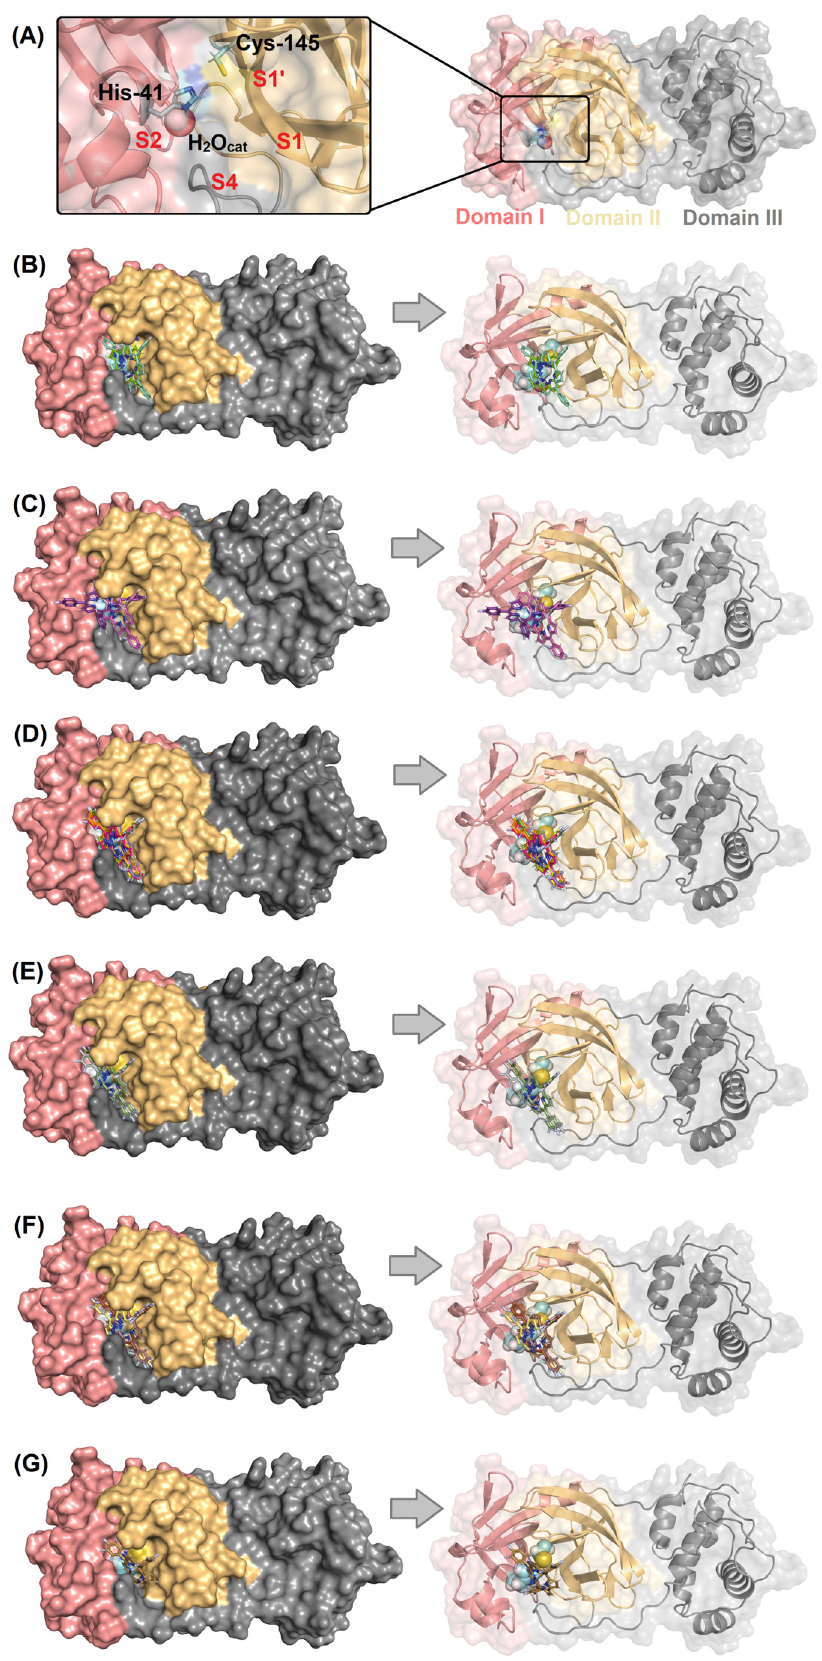
Figure 2. ( A ) The 3D structure for M pro (PDB code: 6LU7) highlighting the catalytic Cys-His dyad (as stick in cyan) and catalytic water (H 2 O cat ) as a sphere. Superposition of the best docking pose for